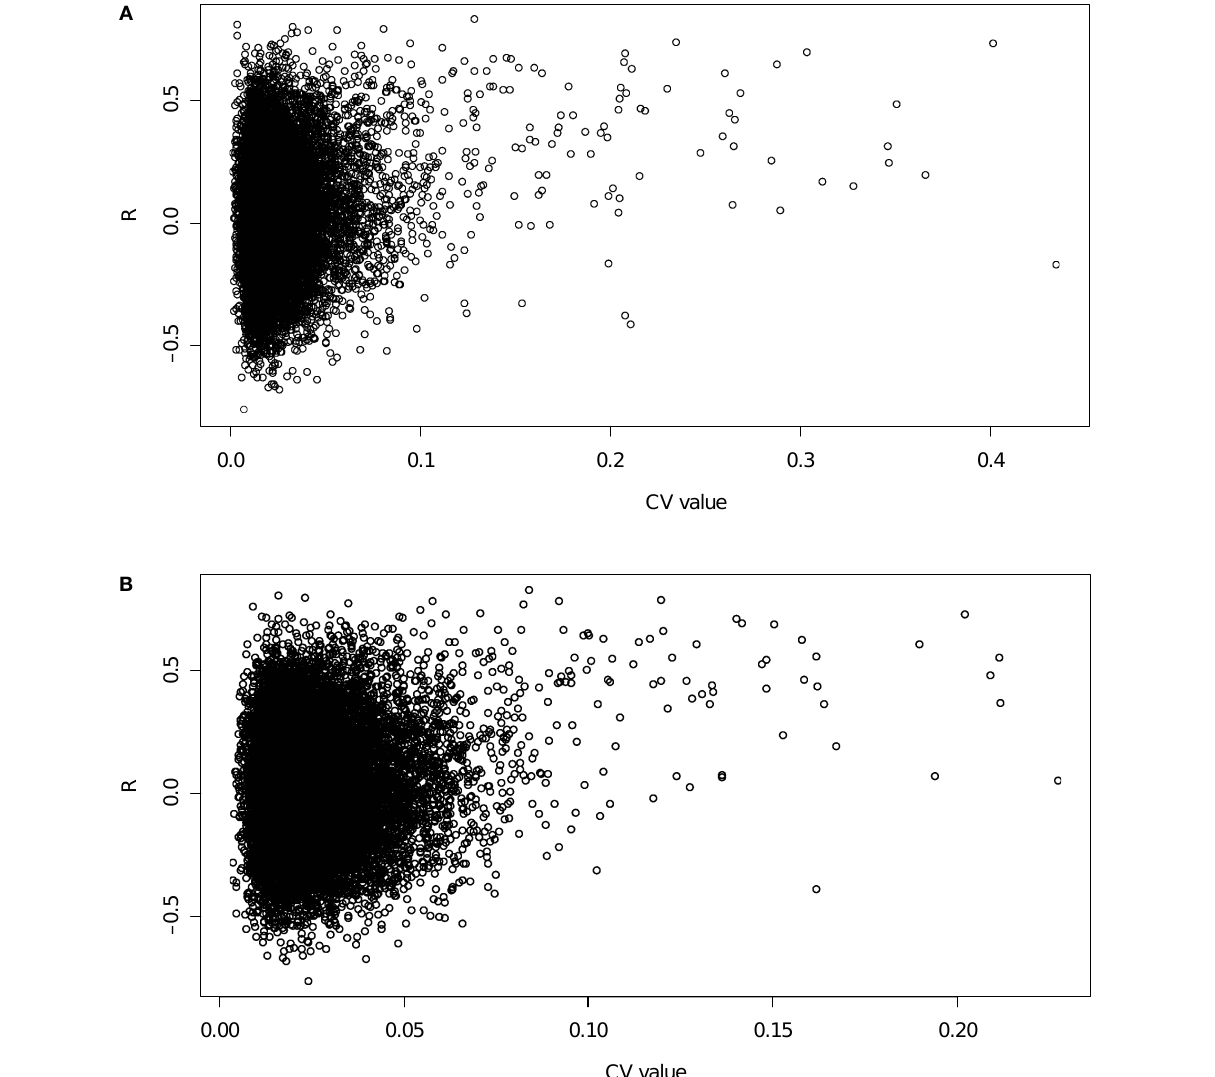
were selected for QTL analysis. Using a signifi cance cut-off